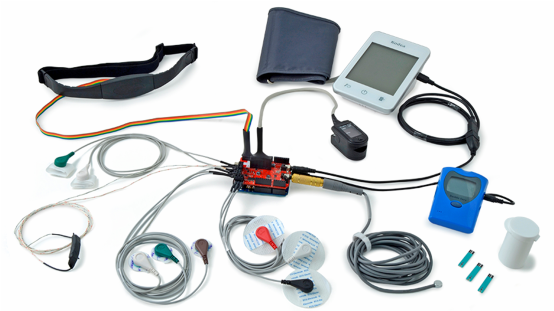
Figure 1. The platform allows us to monitor biometric signals by using different sensors (courtesy of